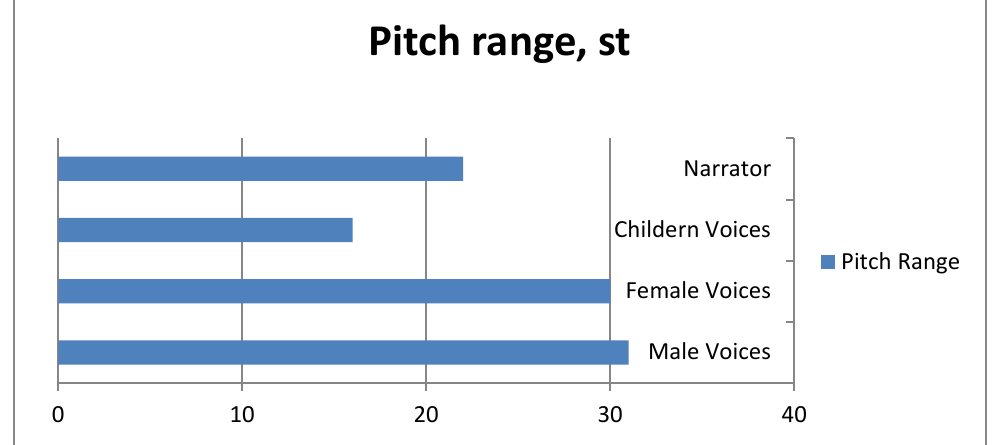
Fig.1 Mean Pitch Range of adult male , adult female and children’s